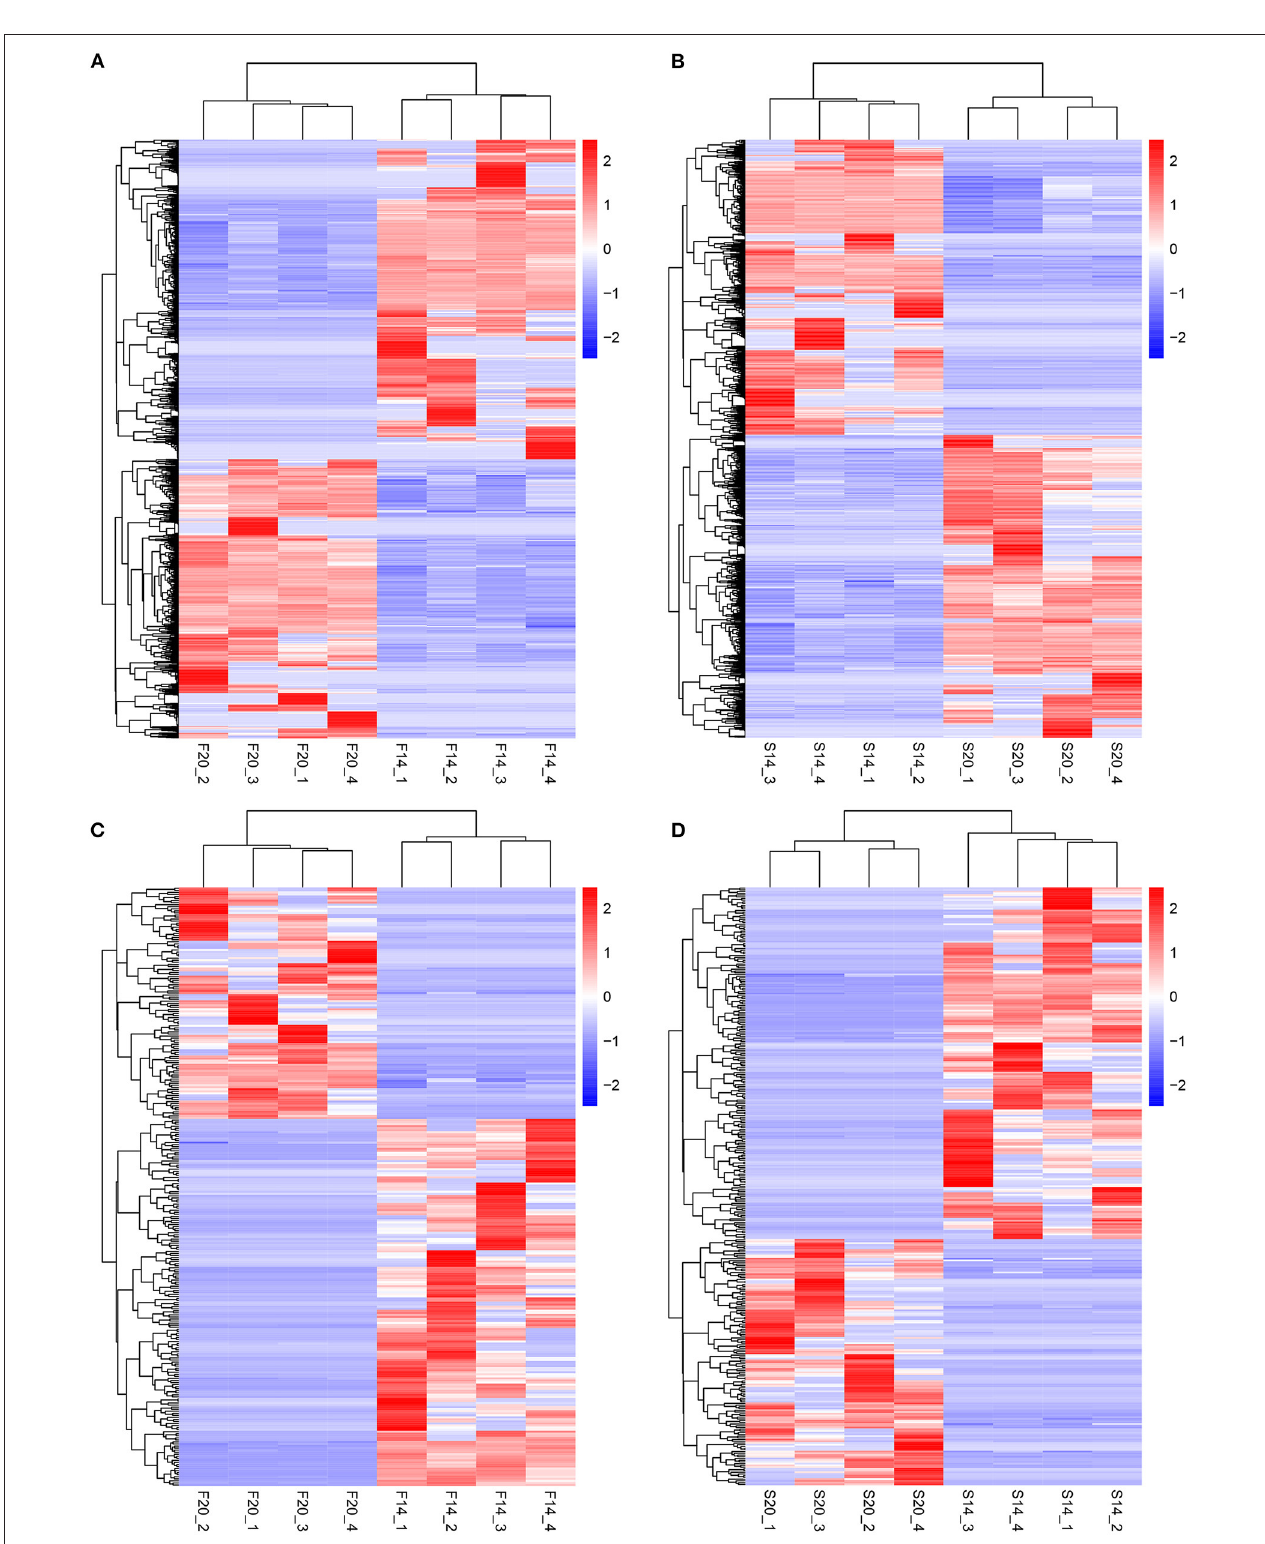
FIGURE 4 | Results of hierarchical clustering analysis. (A) Hierarchical clustering results for mRNAs in F14vsF20; (B) Hierarchical clustering results for mRNAs in S14vsS20; (C) Hierarchical clustering results for lncRNAs in F14vsF20; (D) Hierarchical clustering results for lncRNAs in S14vsS20.